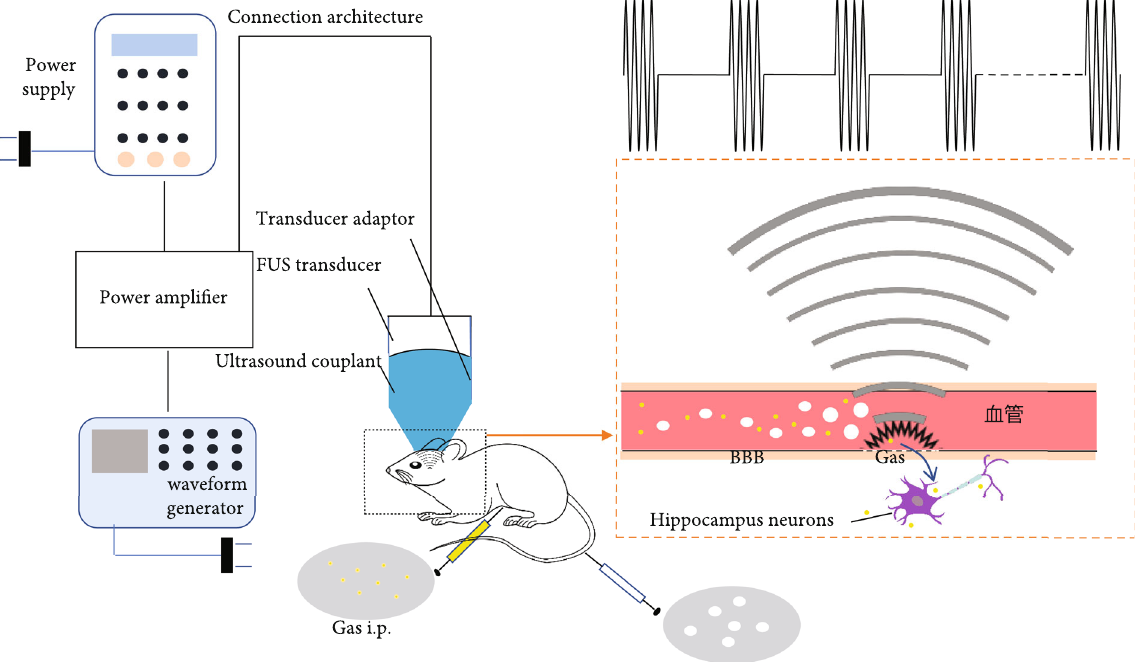
Figure 3: (a) Flow chart of combined treatment (BBB opening via FUS and GAS treatment). (b) Schematic diagram of BBB opening via FUS with the presence of